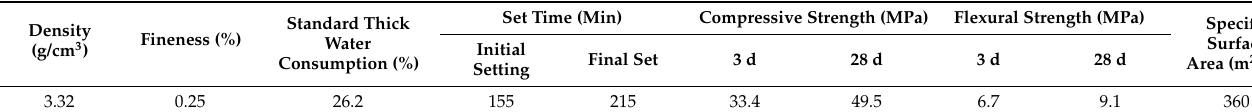
Table 2. Physical properties of cement.